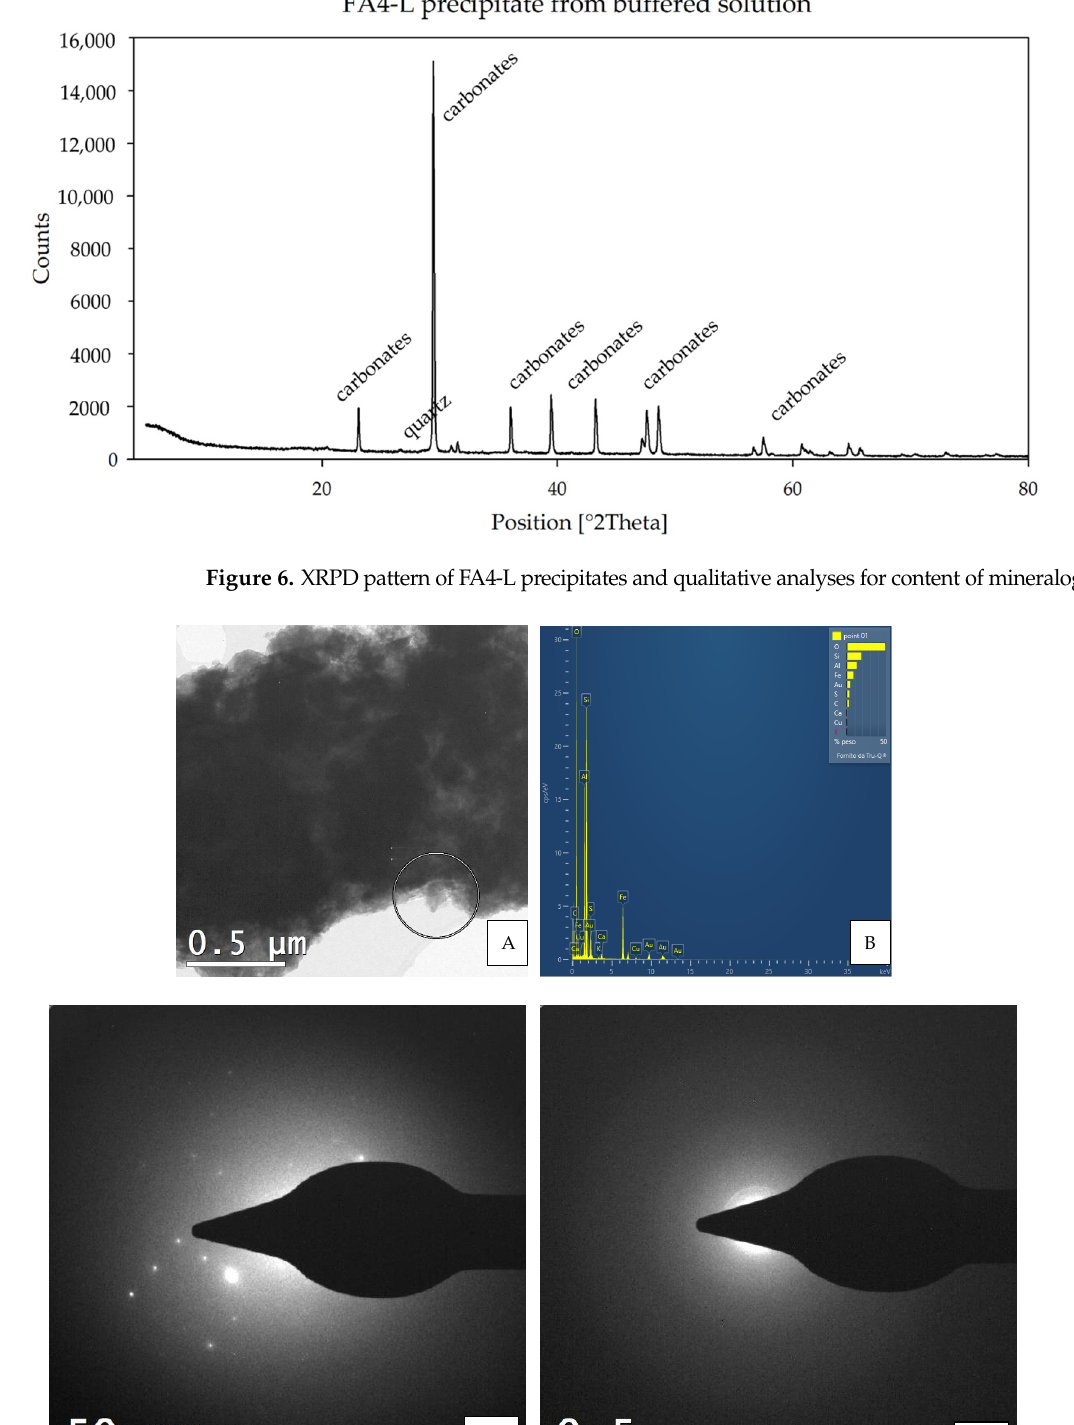
Figure 7. Precipitated phases from FA3-S sample, analyzed by TEM. A nano-crystals aggregate ( A )